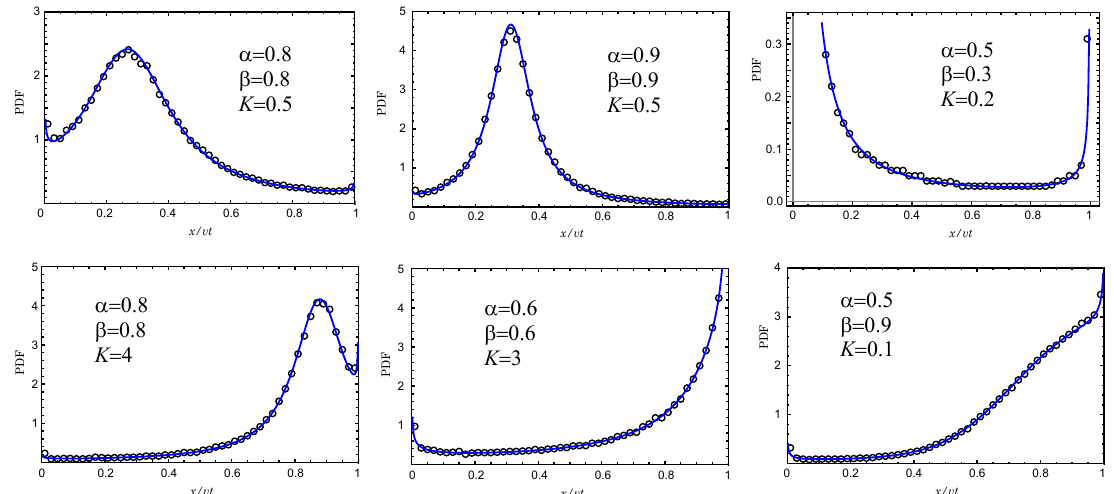
Figure 3. Charge carrier distribution (pdf) for different values of 0 < α = β < 1 and K in comparison with the Monte Carlo simulation